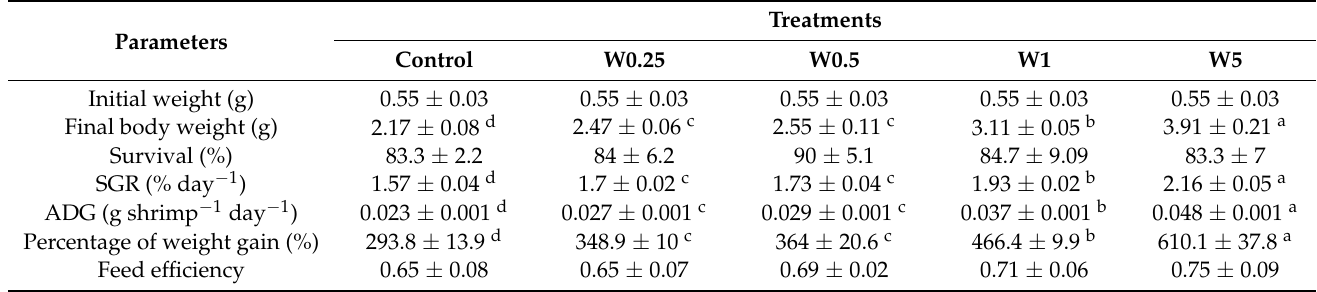
Table 2. Growth performance of Litopenaeus vannamei reared in the water added with Micro-Aid Liquid 10 once per week at the levels of 0 (control), and 0.25 mL m 3 − 1 (W0.25), 0.5 mL m 3 − 1